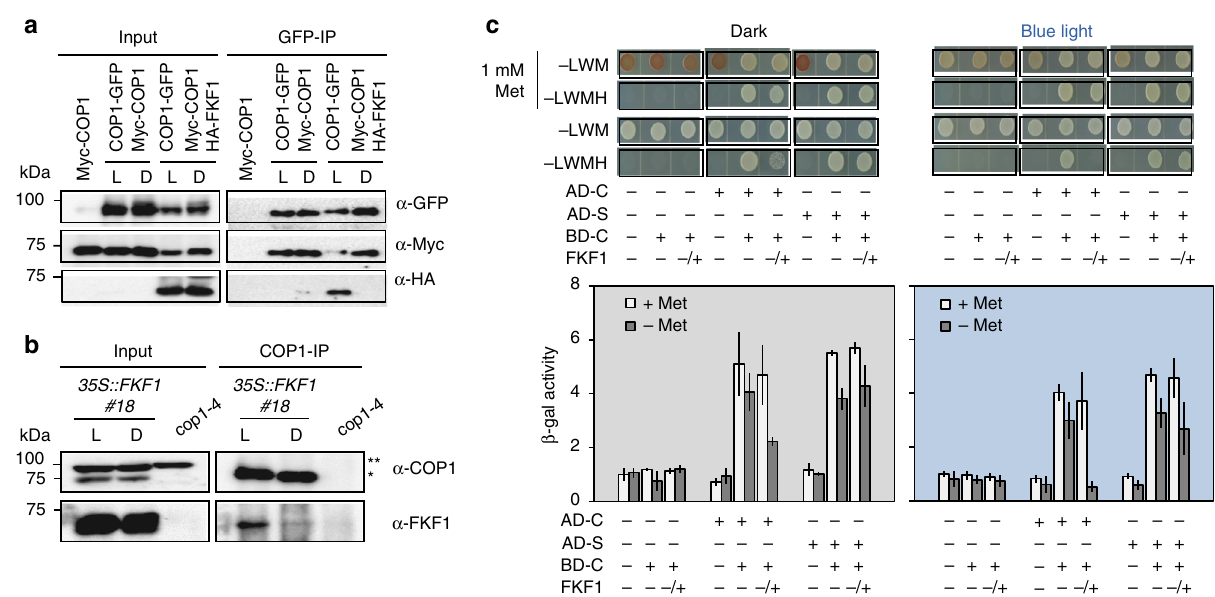
Fig. 4 FKF1 inhibits COP1 homo-dimerization in a light-dependent manner. a FKF1 requires light to interact with COP1 and inhibit COP1 dimerization. In the absence of FKF1, COP1 dimerization occurs in both light and dark conditions. In the presence of FKF1, FKF1 interacts with COP1 only under light in N. benthamiana . Two days after co-in fi ltration, tobacco leaves were harvested under light (L) and dark (D) in LD. b Light-dependent interaction between FKF1 and COP1 in 35S:FKF1 #18. The 10-day-old seedlings were harvested in the light period (L) and dark period (D) in LD. * indicates COP1 and ** indicates non- speci fi c bands derived from an anti-COP1 antibody. FKF1 was detected by an anti-FKF1 antibody. c FKF1 inhibits COP1 dimerization light-dependently in yeast three-hybrid assays. The interactions were evaluated based on yeast cell survival (upper panel), and were further con fi rmed by β -galactosidase ( β - Gal) activity (lower panel). Data are means ± s.d. of three samples. Met, methionine; − LWM, the absence of Leu/Trp/Met in the yeast media; − LWMH, the absence of Leu/Trp/Met/His; AD, activation domain; BD, binding domain; C, COP1; S, SPA1. − or + represent the presence or absence of protein expression, respectively. In FKF1, − /+ indicates the absence of FKF1 in the fi rst and second panels due to the addition of 1 mM Met and the presence of FKF1 in the third and fourth panels because 1 mM Met was not added to the yeast